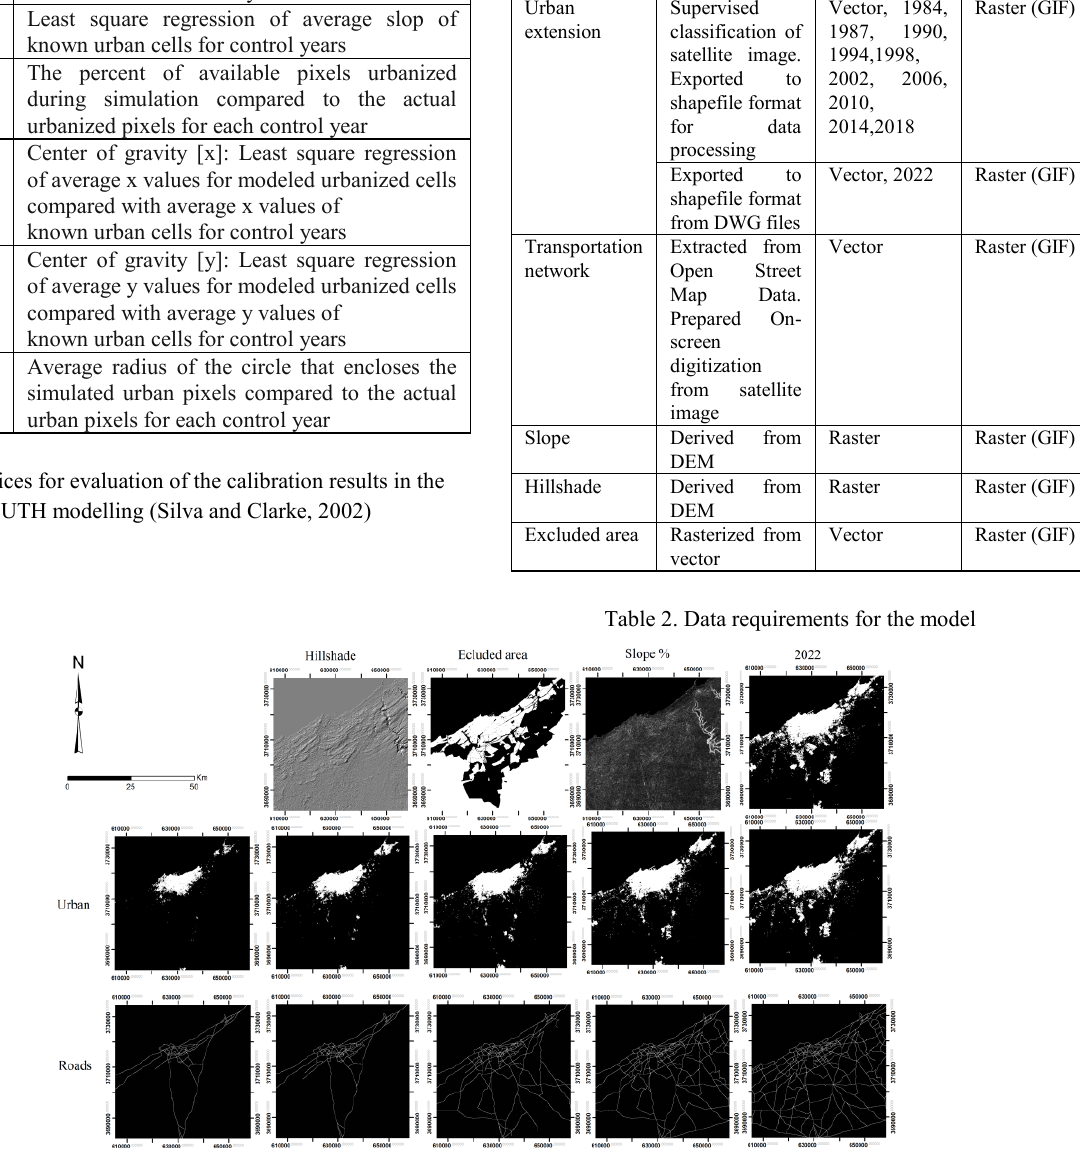
Figure 2. Input Data set for model